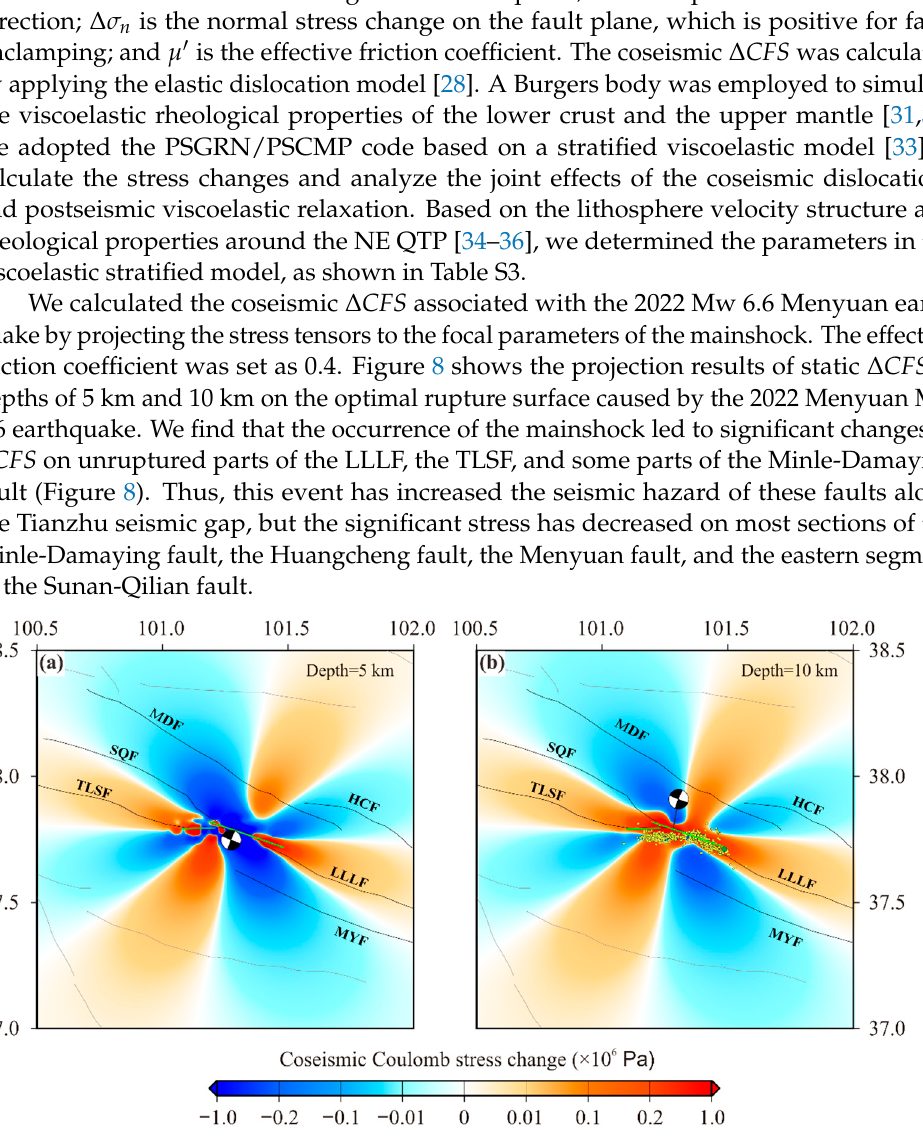
Figure 8. Coseismic ∆ CFS was associated with the 2022 Menyuan Mw 6.6 earthquake at depths of 5 km and 10 km. ( a ) represents a depth of 5 km and ( b ) represents 10 km. The black lines indicate the active faults. The green lines represent the rupturing fault inferred from modeling. Yellow points indicate the relocated aftershocks, and the green dot indicates the largest M 5.3 aftershock.